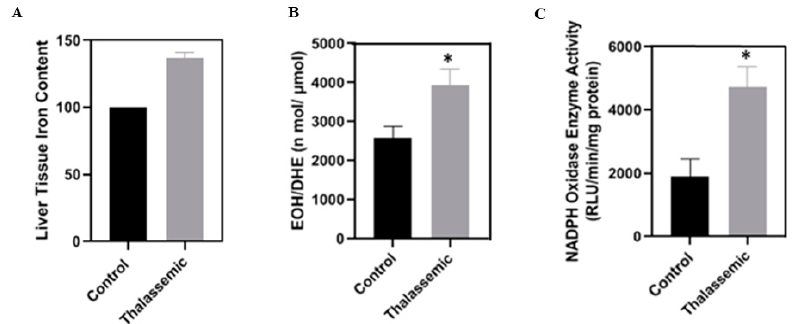
Figure 2. ( A ) Assessment of tissue iron content using HPLC. ( B ) Superoxide generation evaluated using HPLC. ( C ) using HPLC. ( C ) NADPH-dependent superoxide generation assessed by lucigenin-enhanced chemi- NADPH-dependent superoxide generation assessed by lucigenin-enhanced chemiluminescence. Values are the means ± luminescence. Values are the means ± SEM from 4 different mice in each group ( n = 4). * p < 0.05 SEM from 4 different mice in each group ( n = 4). * p < 0.05 versus control. EOH: 2-hydroethidium; DHE: dihydroethidium. versus control. EOH: 2-hydroethidium; DHE: